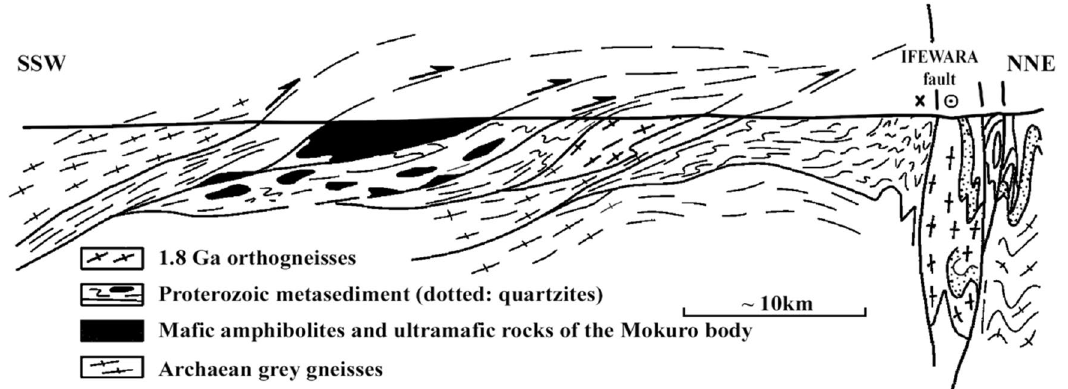
Figure 2. Cross-section of Ife–Ilesha schist belt within the study area, with equal vertical and horizontal scales adopted from Ref. 12 . The profile location is shown in Fig. 1. The interpretative cross-section showing geometrical relationships between Archaean basements, Proterozoic cover and the Ifewara fault which is the dominant feature of the study area as shown in Fig.